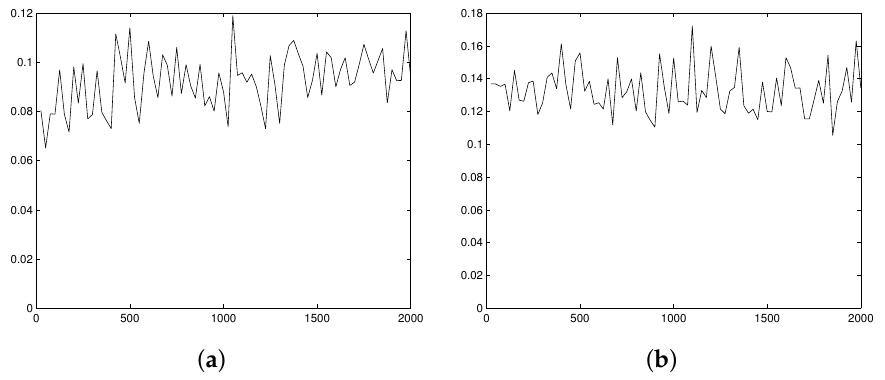
Figure 4. MSE of kernel estimators (with piecewise linear kernel characteristic function) as a function of the sample size n . ( a ) Laplace density function ( r = 1, MSE multiplied by n 3/4 ). ( b ) Gamma density function ( k = 3, r = 2, MSE multiplied by n 5/6 ).